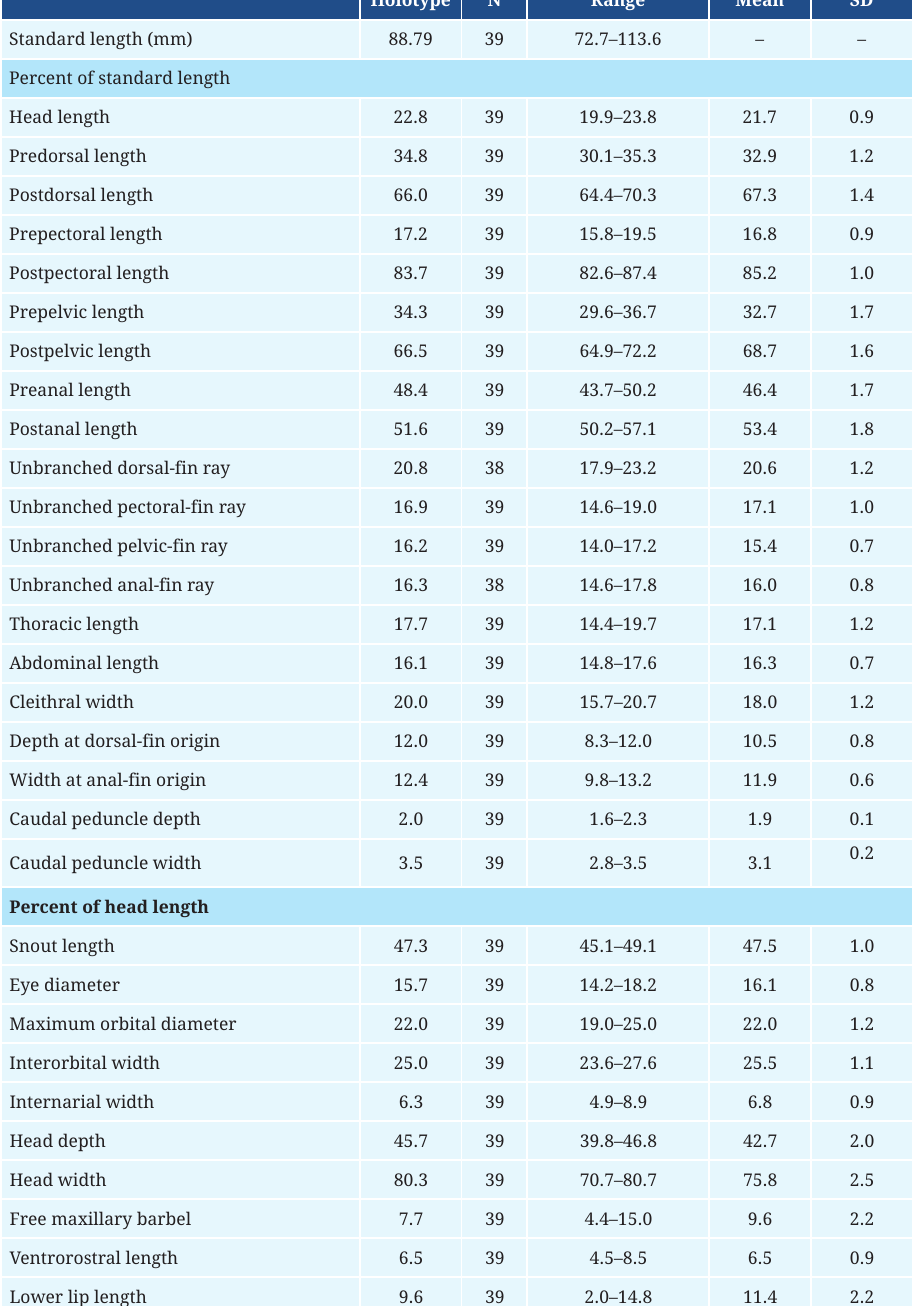
TABLE 2 | Morphometric data of holotype and paratypes of Rineloricaria nudipectoris . Range includes the holotype. N = number of specimens measured; SD = standard deviation. Holotype